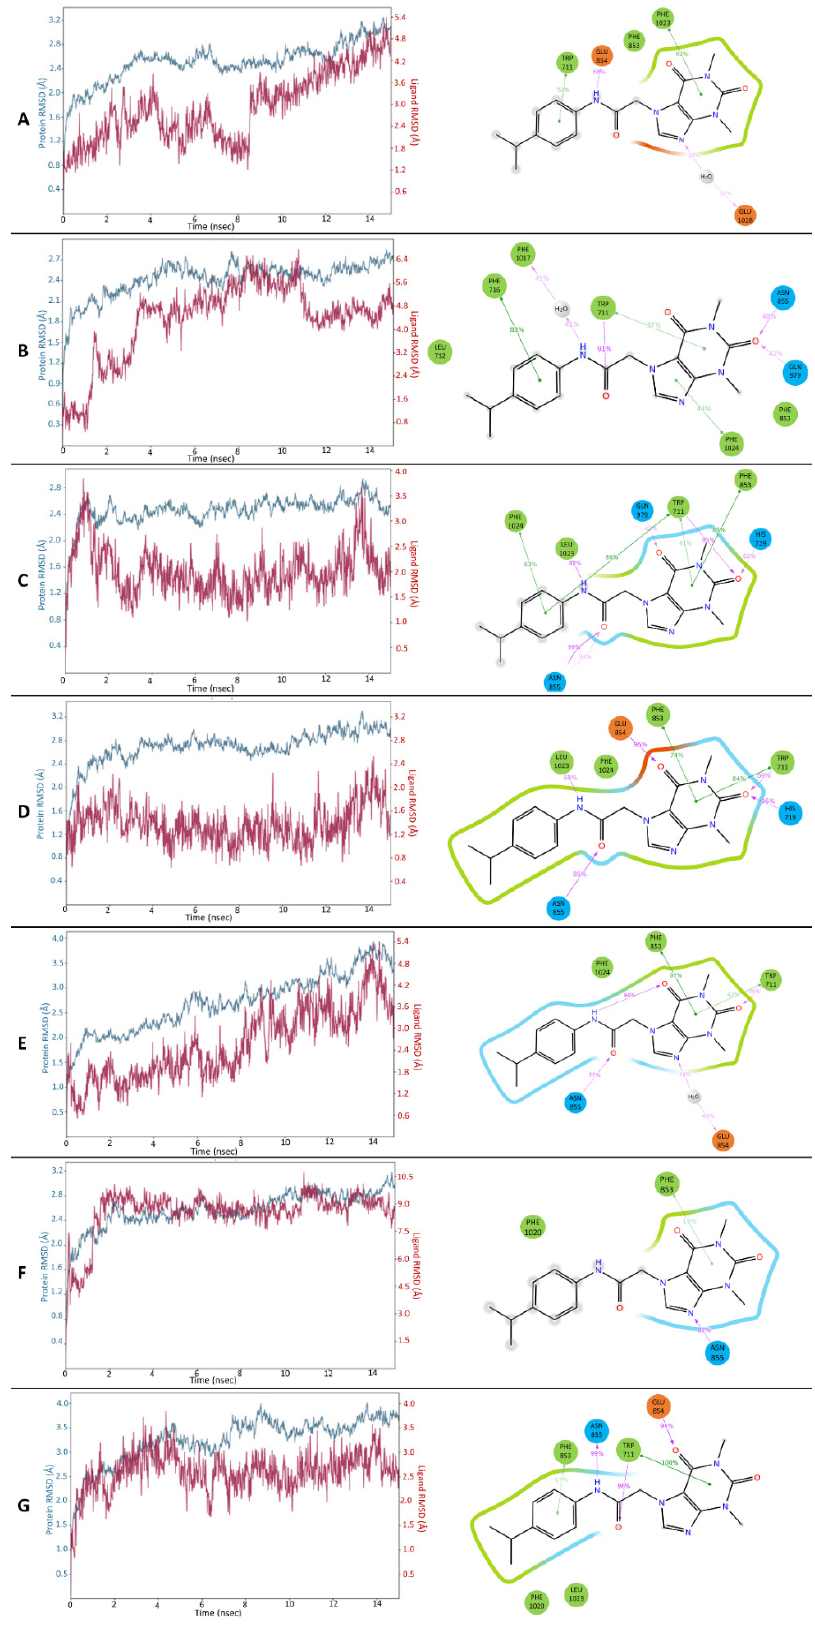
Figure 7. Results of 15 ns MD simulations for all complexes ( A – G ): RMSD plots (protein—blue, ligand—red), binding interactions formed, and their durability (percentage of the total simulation time).